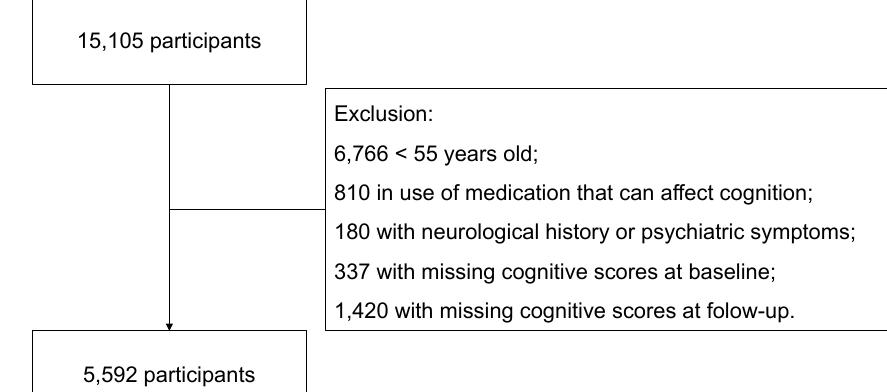
Figure 1. Sample selection